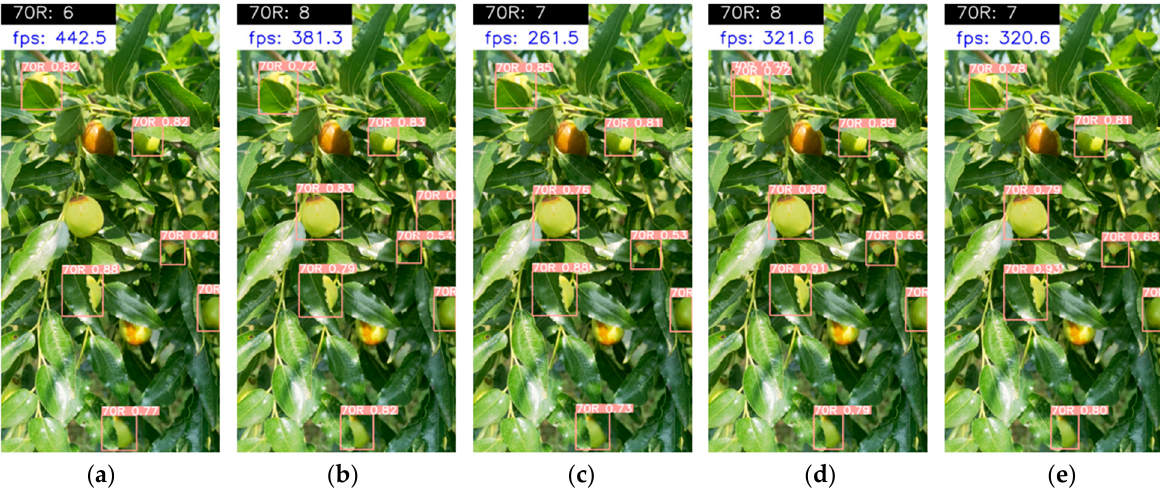
Figure 7. The sorted and counted target of 70R from an image tested on: ( a ) YOLOv3-tiny; ( b ) YOLOv4-tiny; ( c ) YOLOv5s; ( d ) YOLOv7-tiny; ( e ) YOLO-Jujube method.